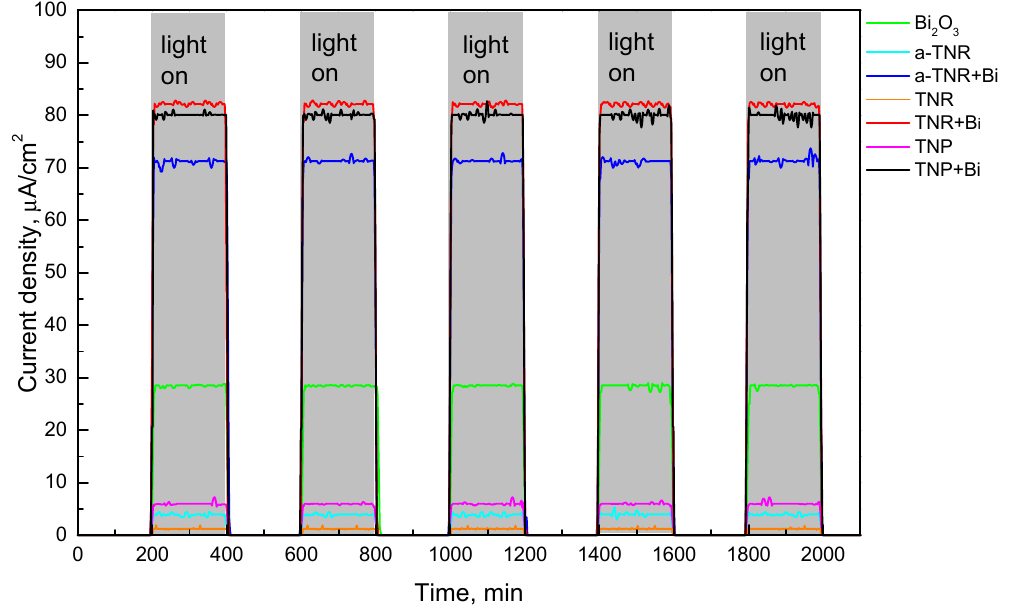
Figure 6. Photocurrent densities at photoelectrode measured under intermittent visible-light (LED light) irradiation in 0.1 M KOH.